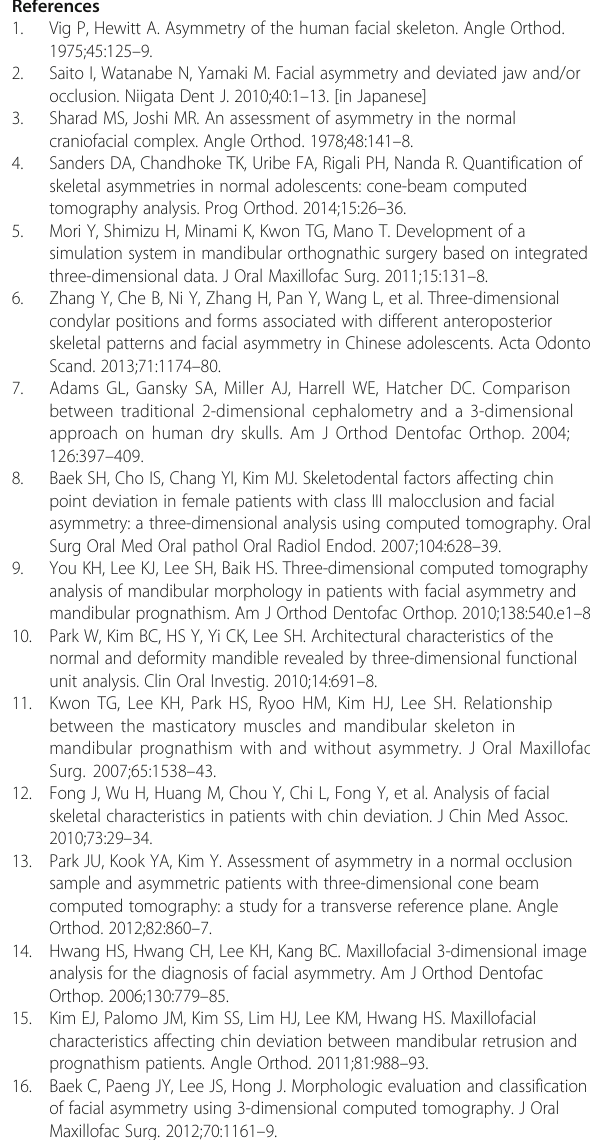
Abbreviations 3D-CT: Three-dimensional computed tomography; DICOM: Digital Imaging